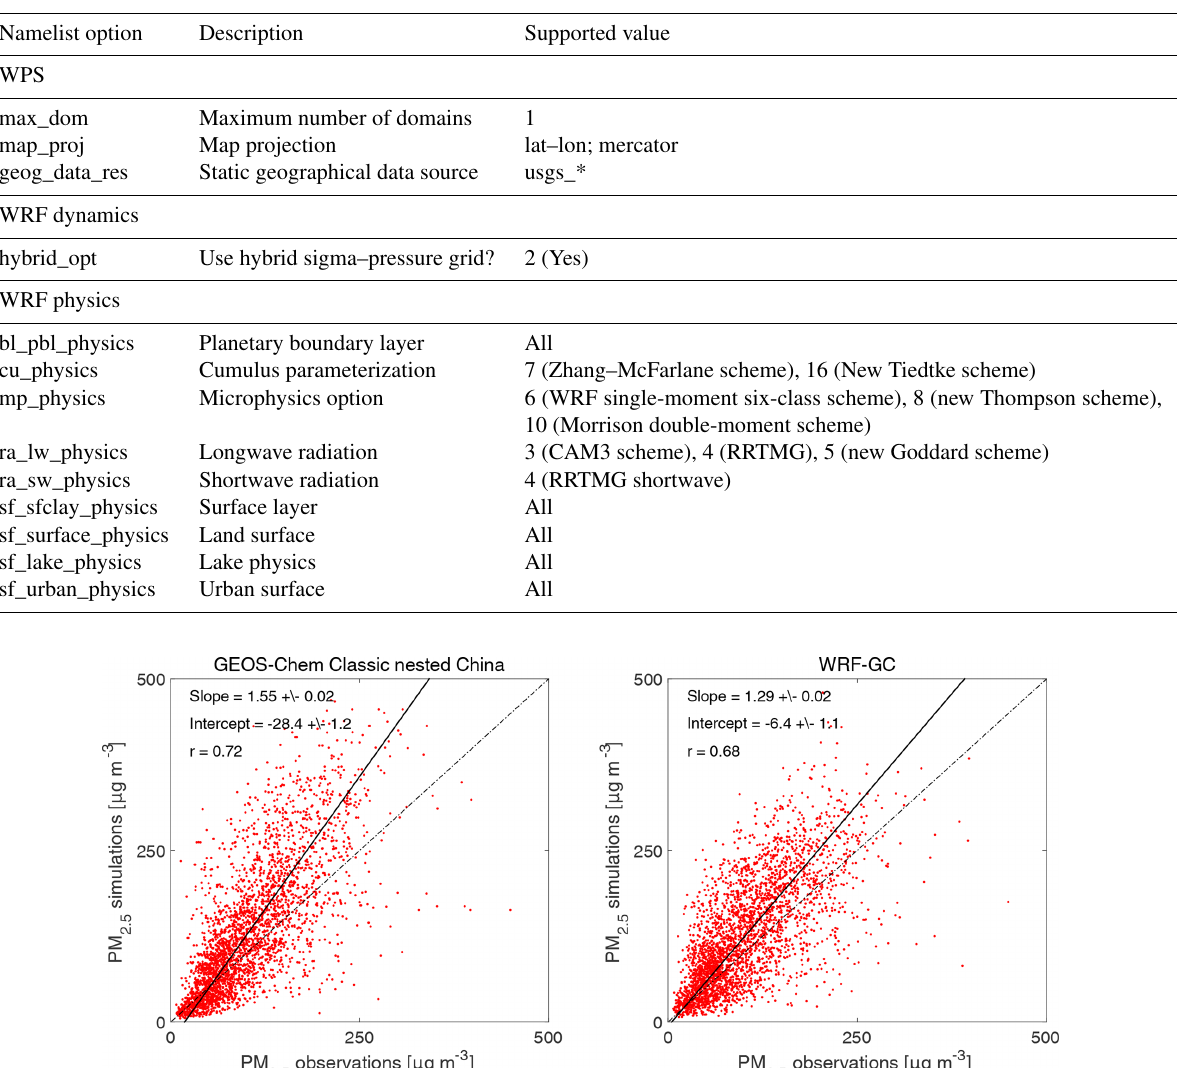
Table 3. List of WRF configuration and physical options supported in WRF-GC v1.0.